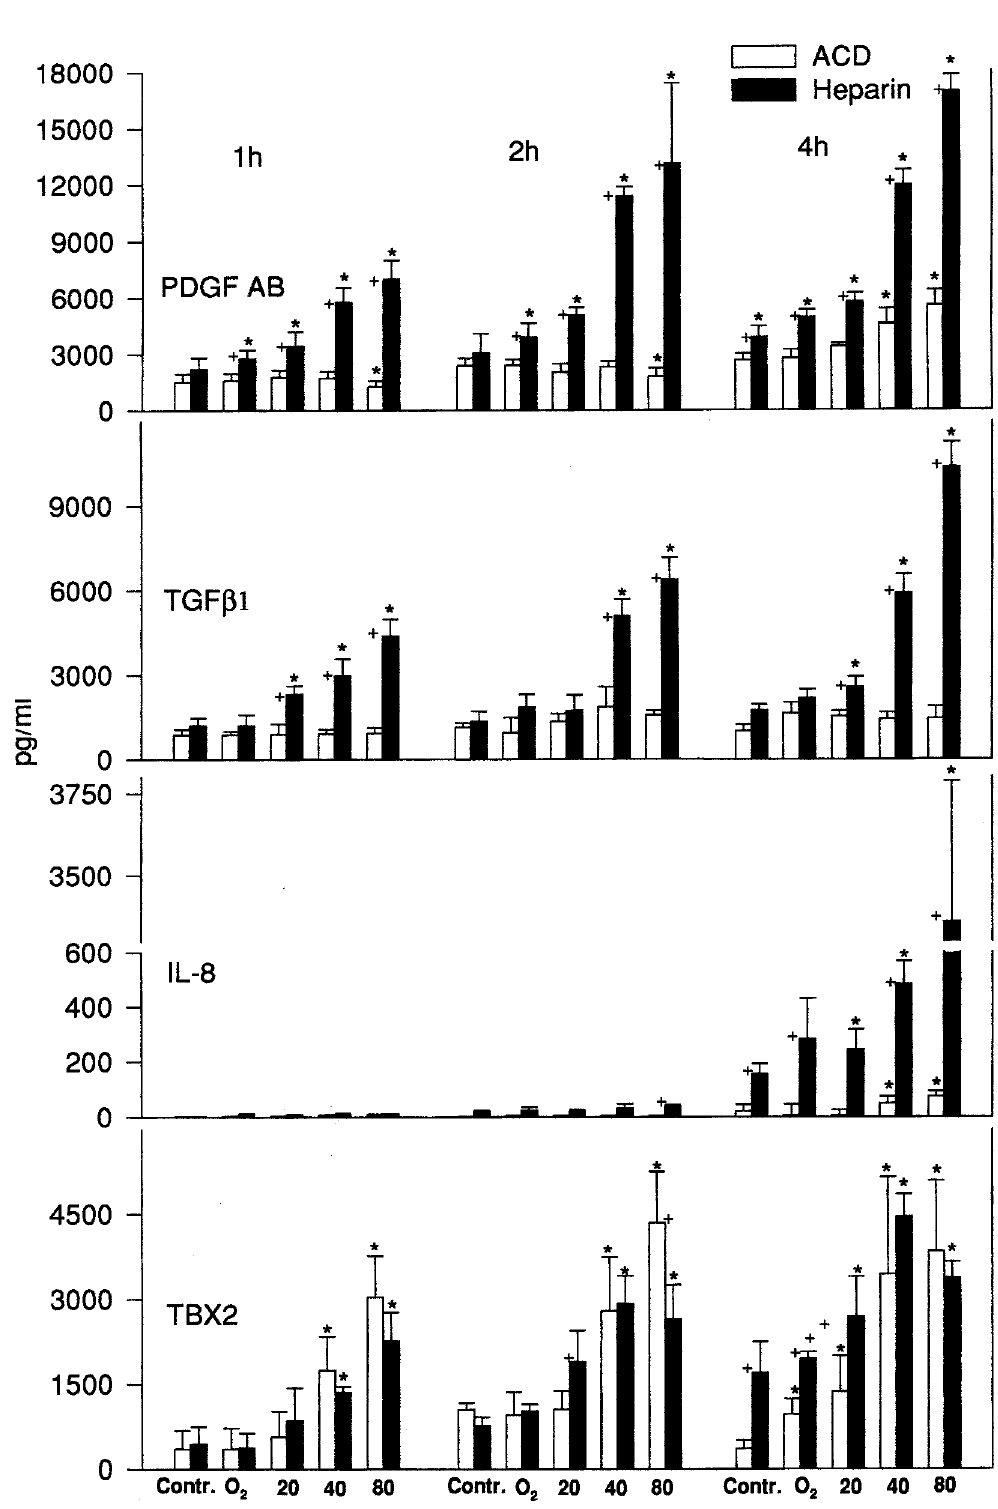
FIG. 2. Release of factors from human platelets during 1, 2 and 4h incubation. The same PRP samples collected either in heparin or ACD were either not exposed (control), or exposed to O 2 alone, or O 2 –O 3 at 20, 40 and 80 m g/ml concentration for 30sec before incubation. The statistical significance has been indicated with a (*) for intergroup and with a (+) for intragroup